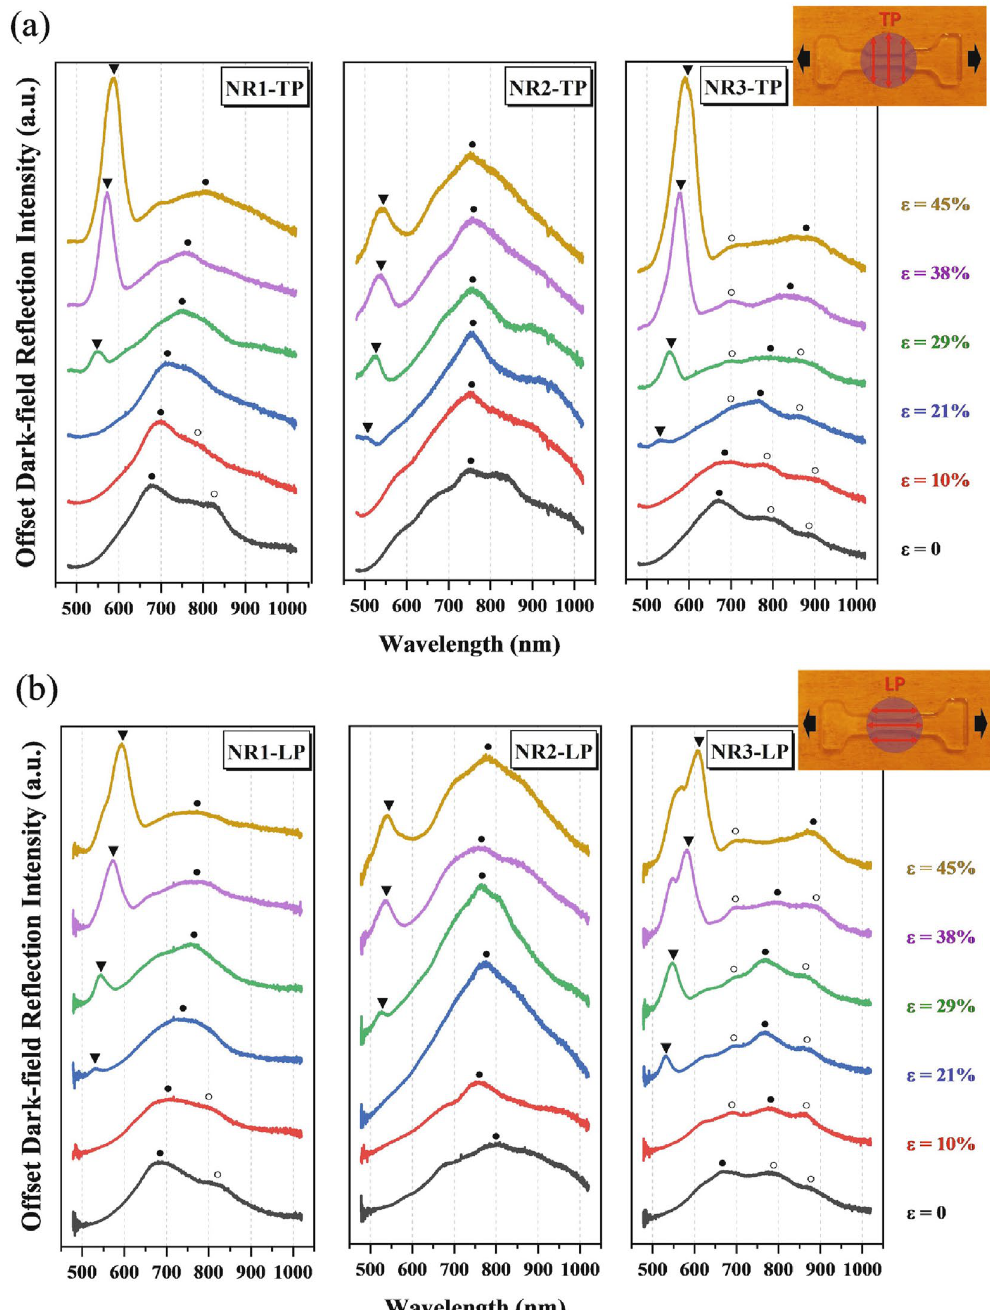
Fig. 2 Dark-field reflection spectra for NR1, NR2 and NR3 arrays under both transverse ( a ) and longitudinal polarizations ( b ). The grating and respective highest intensity LSPR modes are marked with triangles and full circles, respectively, where the open circles for the NR1 and NR3 array represent additional LSPR modes that in NR1 are merging. The top-right figures schematically show the polarization conditions and strain applied to PDMS, where the black and red arrows are the stretching and polarization directions, respectively, and the purple circles represent the areas of the top-view dark-field